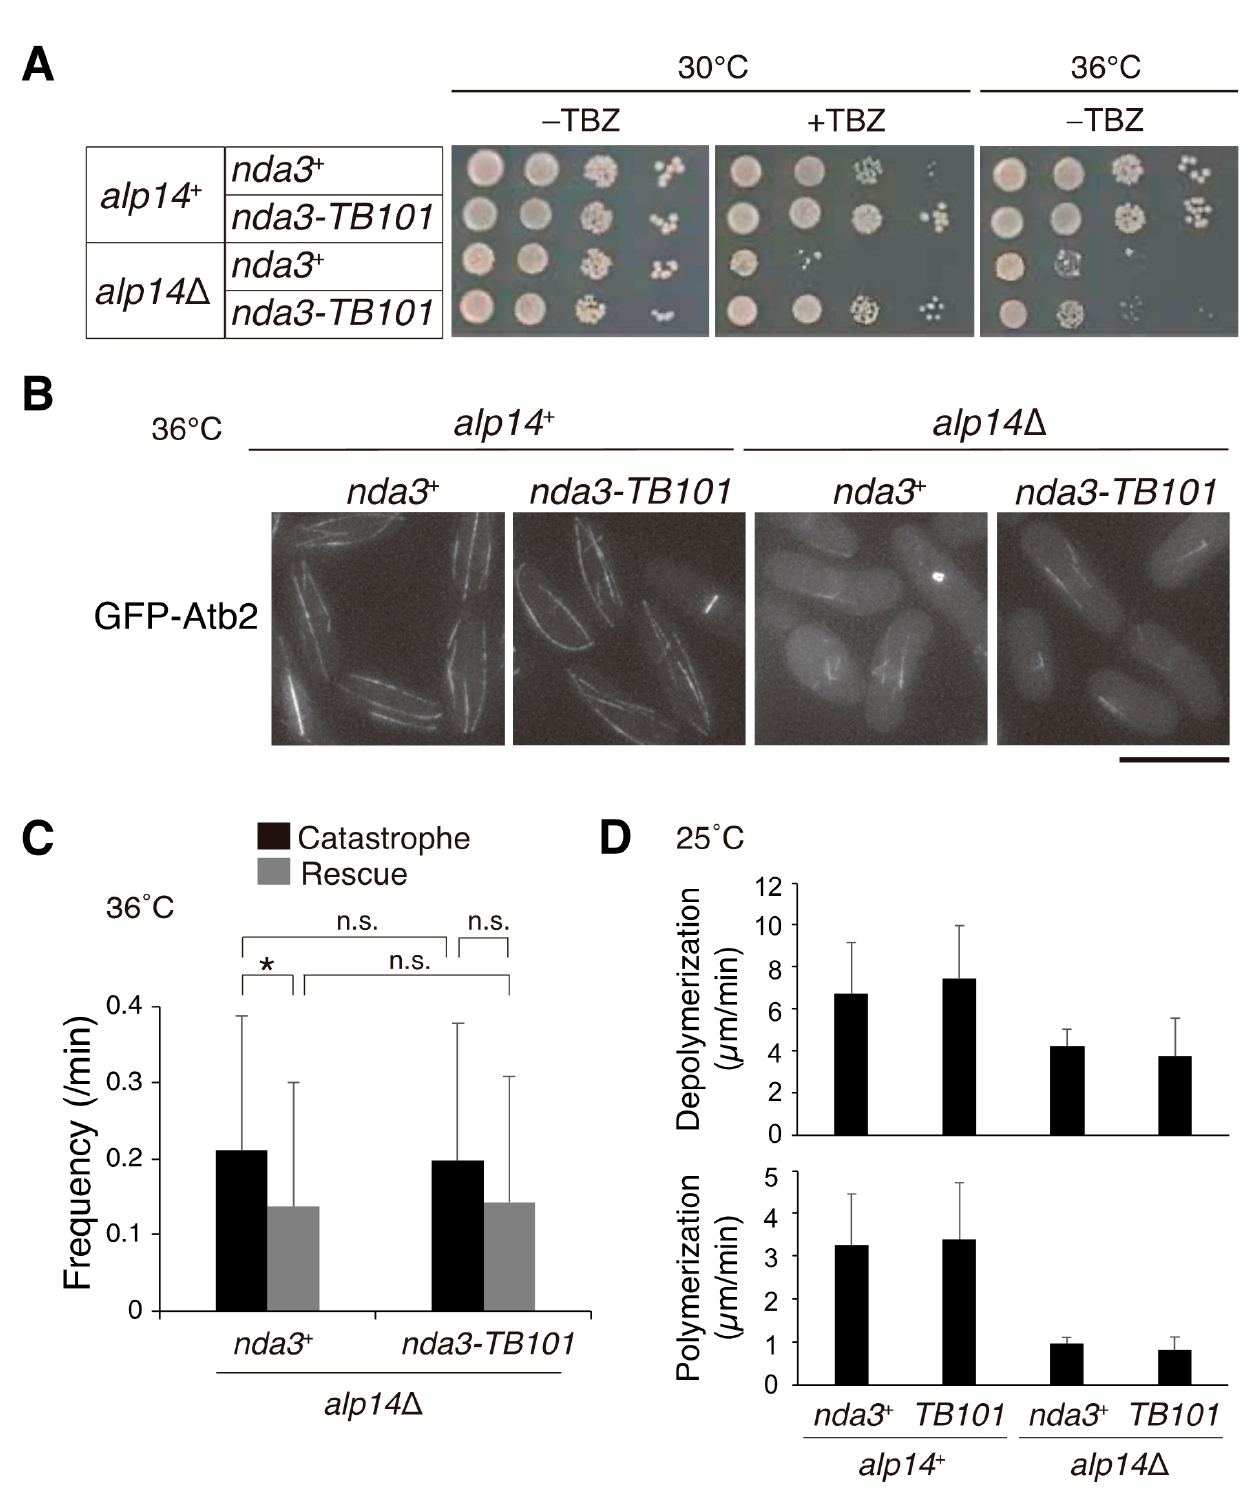
Figure 7. The nda3-TB101 mutation partially suppresses phenotypes of the alp14 deletion mutant. ( A ) Ten-fold serial dilutions of cells with indicated genotypes in rich media without (–TBZ) or with TBZ (10 µ g/mL). Plates were incubated at 30 ◦ C or 36 ◦ C for 4 days. ( B ) Behavior of cytoplasmic microtubules at 36 ◦ C was monitored with GFP-Atb2 in cells with indicated genotypes. Scale bar, 10 µ m. ( C ) Frequencies of microtubule catastrophe and rescue at 36 ◦ C per minute per cell were counted. Bundles, n > 40. * p = 0.041 < 0.05; n.s., not significant. ( D ) Velocities of microtubule polymerization and depolymerization were calculated in cells with the indicated genotypes (25 °C). Bundles, n = 10.